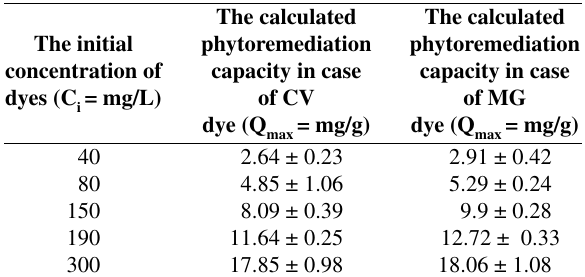
Table 1. The calculated Lemna minor phytoremediation capacity (Q ) after the removal experiments with CV and MG dyes; C max 40–300 mg/L, m